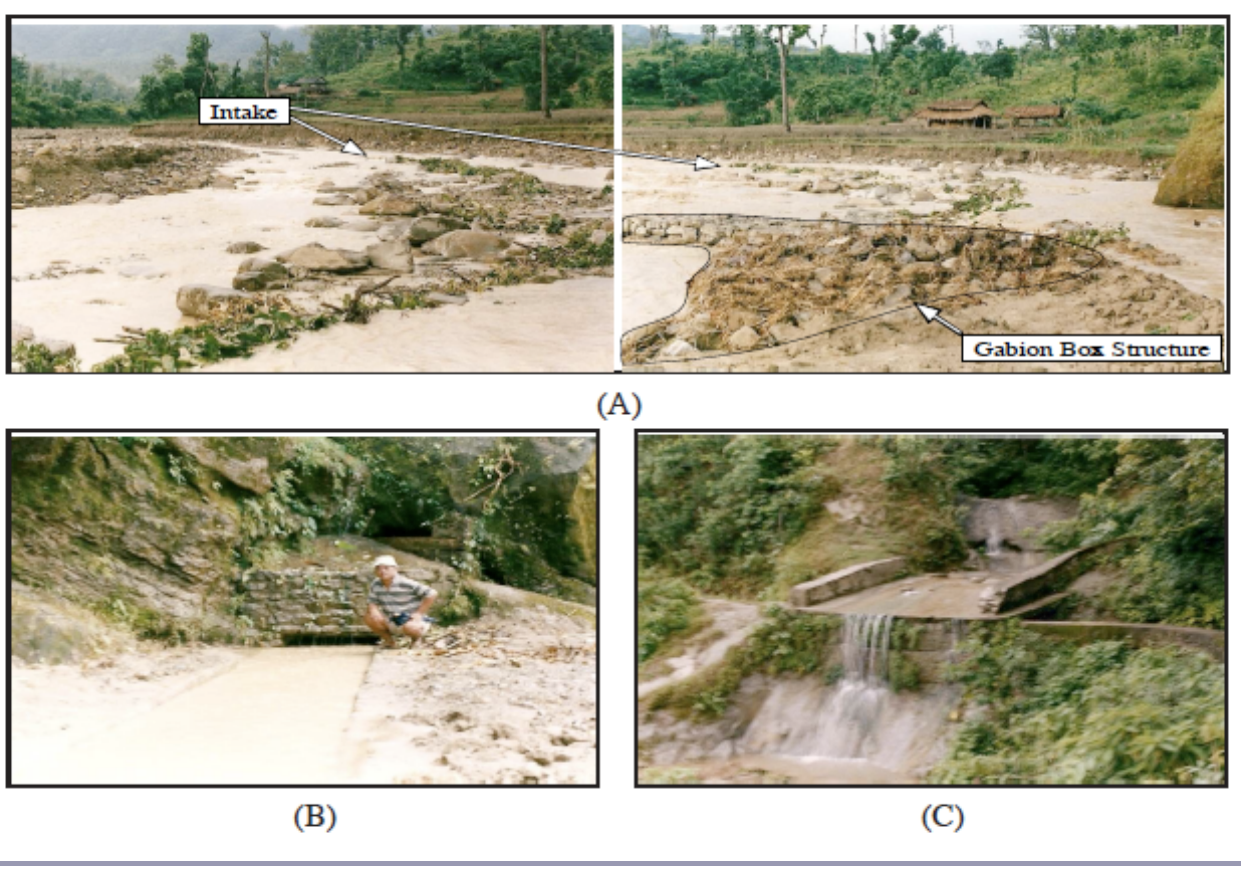
Fig. 2 . Pumpa irrigation infrastructure. (A): Canal intake showing gabion block structure. Arrows showing intake indicate common reference point in the photos. (B): diverted water entering concrete intake and flow control gate. (C): Example of overpass structures and retaining